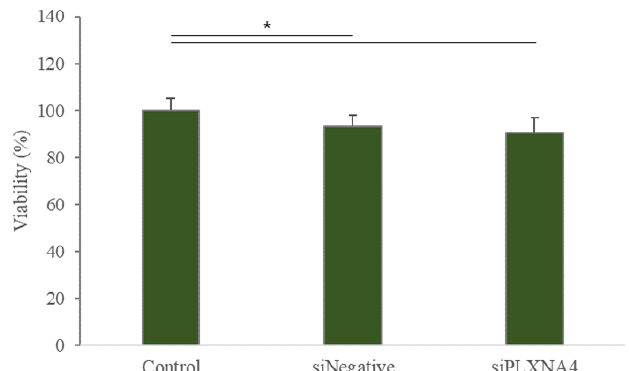
deviations ( n = 3). ** p < 0.01.